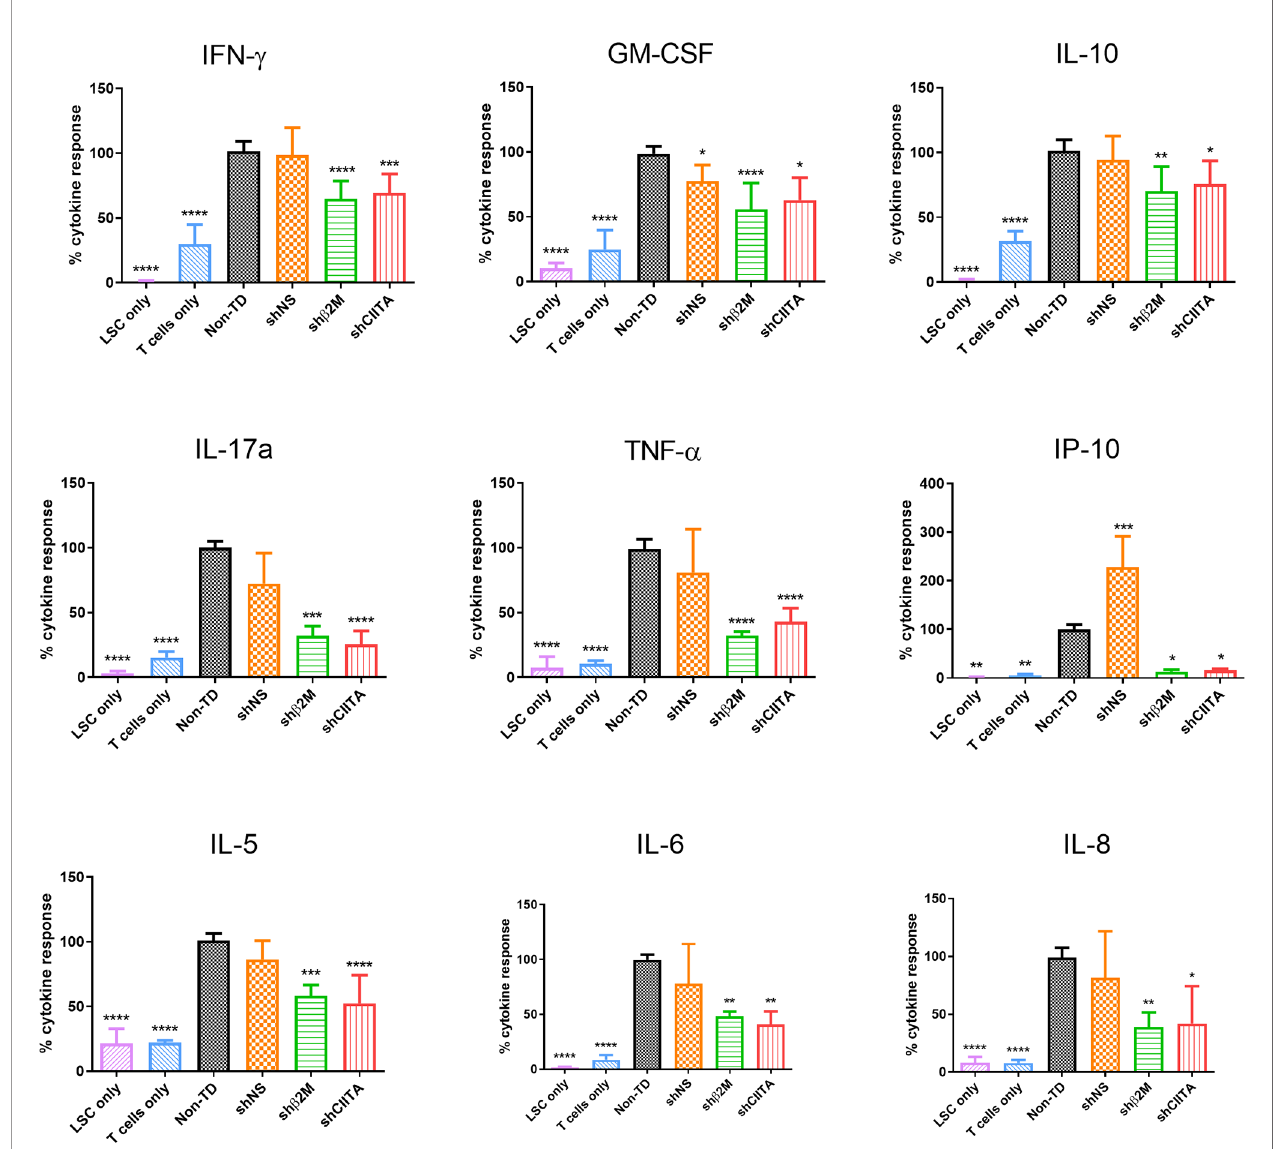
FIGURE 6 | T-cell cytokine response is reduced in presence of HLA silenced limbal stem cells. Percentage of cytokine release (Interferon (IFN) g , Interleukin (IL)-10, granulocytes-macrophage colony-stimulating factor(GM-CSF), IL-17a, IL-5, IFN g -induced protein 10 (IP-10),IL-6, IL-8 andtumornecrosisfactor(TNF) a byallogeneic T cells co-cultured with non-transduced (Non-TD), non-silenced (shNS)and silenced (sh b 2M or shCIITA) limbal stem cells(n=5). Statistical analysis was performed byone-way ANOVA and data are presented as mean ± SDand statistical comparison was done takingNon-TDLSCs as reference. *p < 0.05 , **p < 0.01 , ***p < 0.001 , ****p <